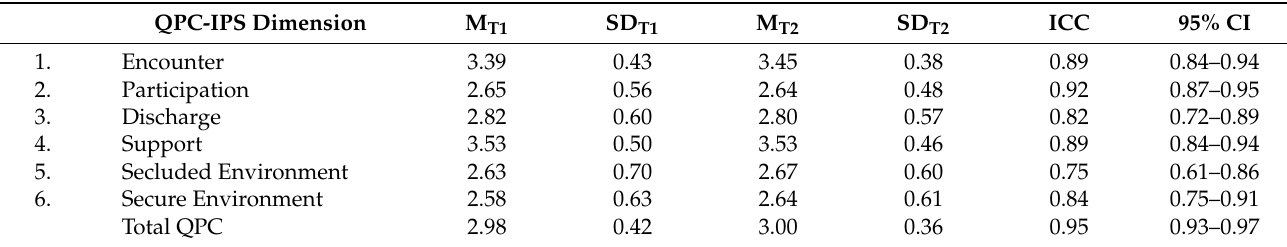
Table 1. Test-retest statistics for the QPC-IPS among staff in inpatient psychiatric care at Time 1 (T1) and Time 2 (T2) × months later.